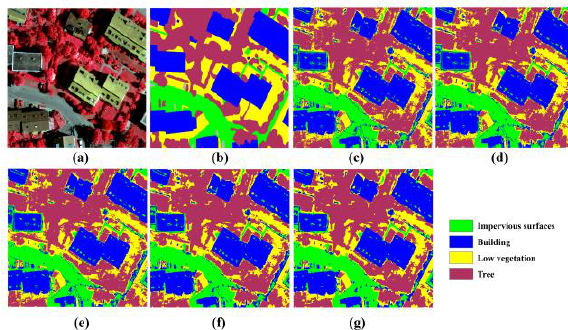
Figure 5. Vaihingen image and its classification results: (a) false color composite of the Vaihingen image; (b) reference map; (c) OCM; (d) CM_Distance; (e) CM_Eastman’s U; (f) CM_Entropy; (g) CM_Proposed.